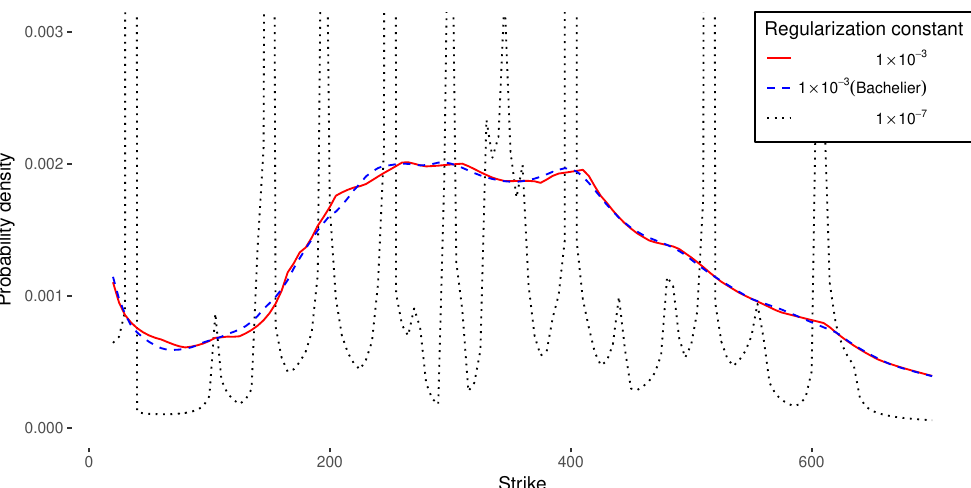
Figure 4. Implied probability density for the exponential B-spline collocation, calibrated to 1 m TSLA options, with different regularization constants.